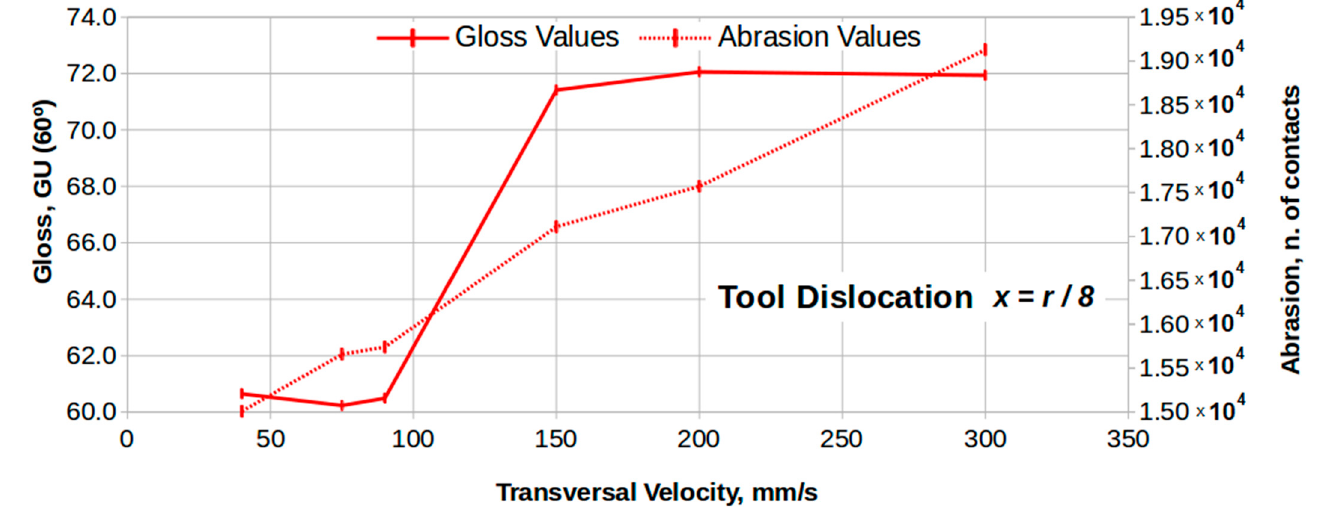
Figure 12. Comparison of abrasion and gloss results, both as functions of transverse velocity V T , for x = r x = r /8.